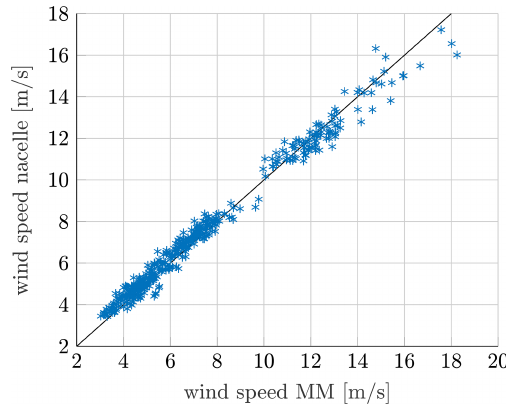
Figure 8. Measured nacelle anemometer wind speed at WTG 2 over the met mast wind